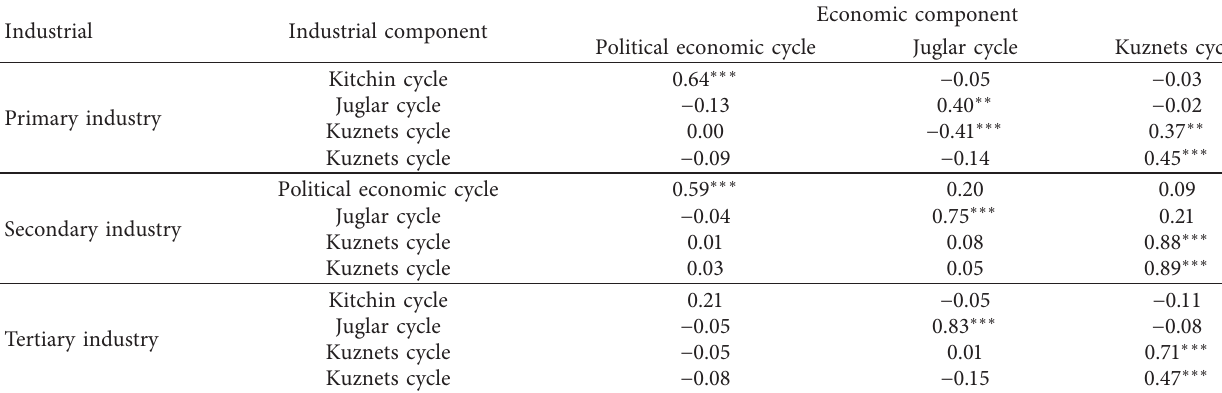
Table 4: Correlation between industrial and the economic cycle components of Jilin